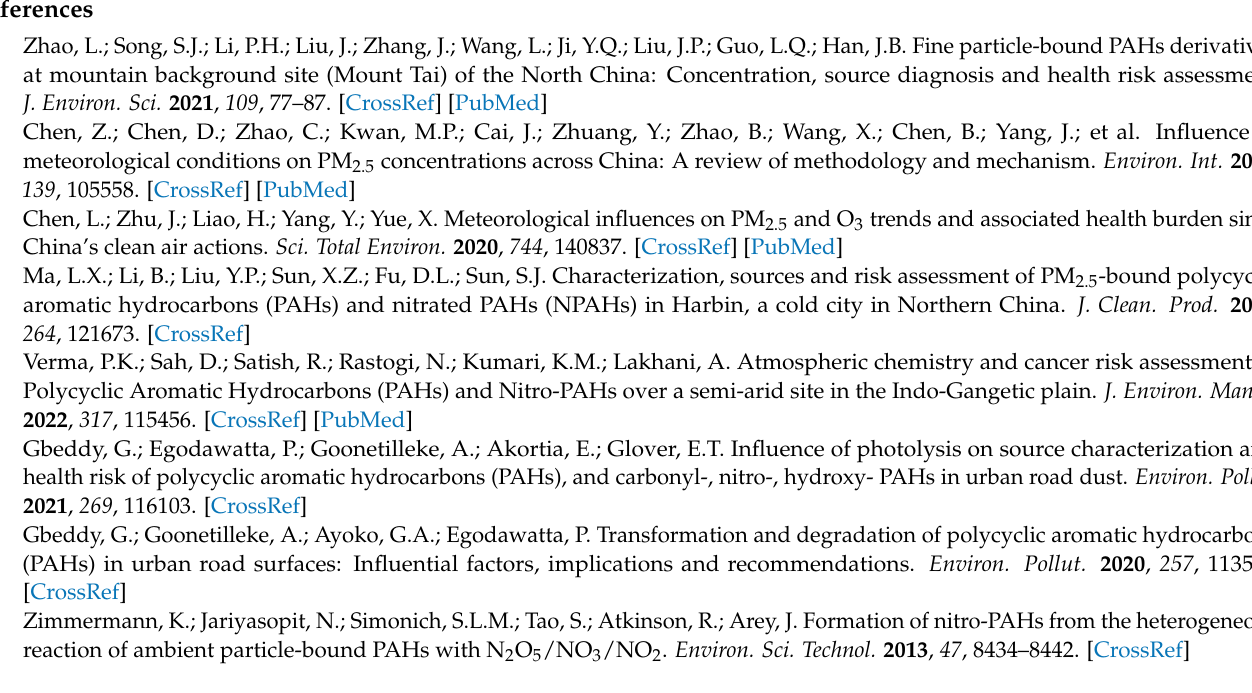
Table S2: Parameters used in the average daily exposure assessment; Table S3: Correlation coefficients and p -values between total nitro-PAHs and meteorological parameters with different airborne particle in Haizhu District in 2019. References [34,46] are cited in the supplementary